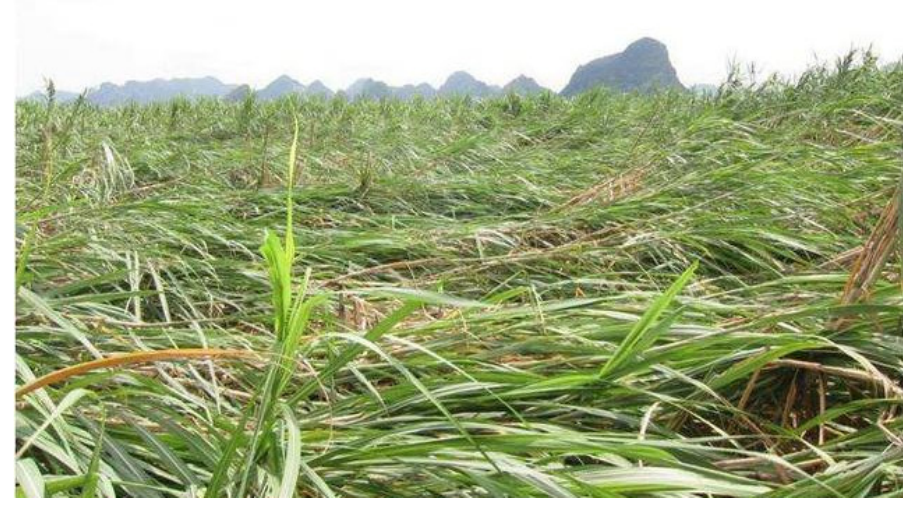
Figure 1. LS after typhoon.